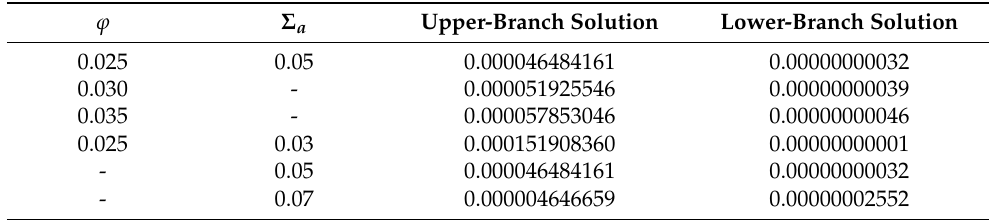
Table 5. Quantitative values of the Nusselt number for the upper- and lower-branch outcomes with several values of ϕ and Σ a when Pr a = 1.0, Sc a = 10.0, Pr = 6.2, ε a = − 1.2, and γ s = 0.5. ϕ Σ a Upper-Branch